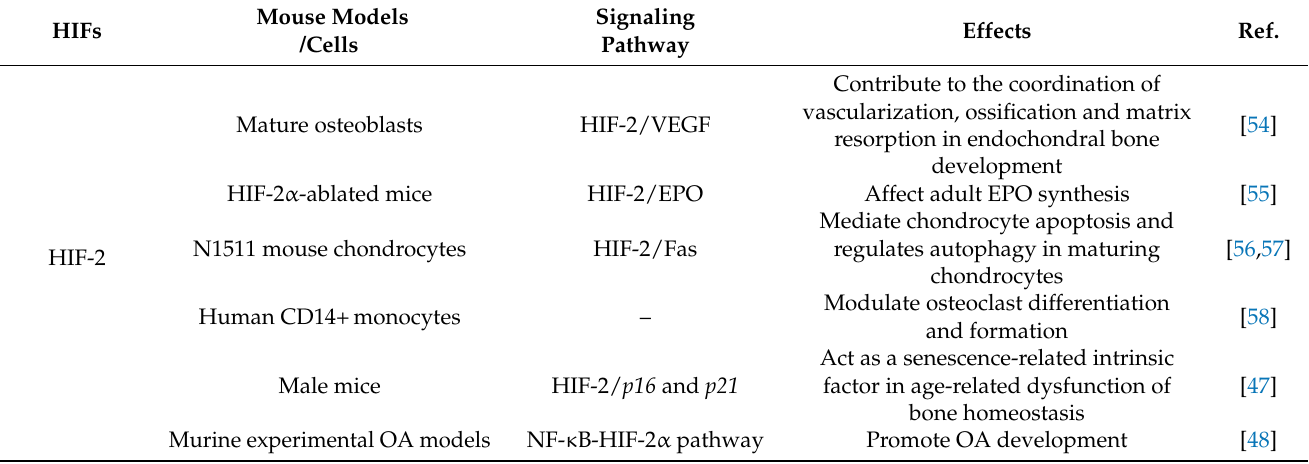
Table 2. HIF-2 functions through regulating different signals in different animal models or